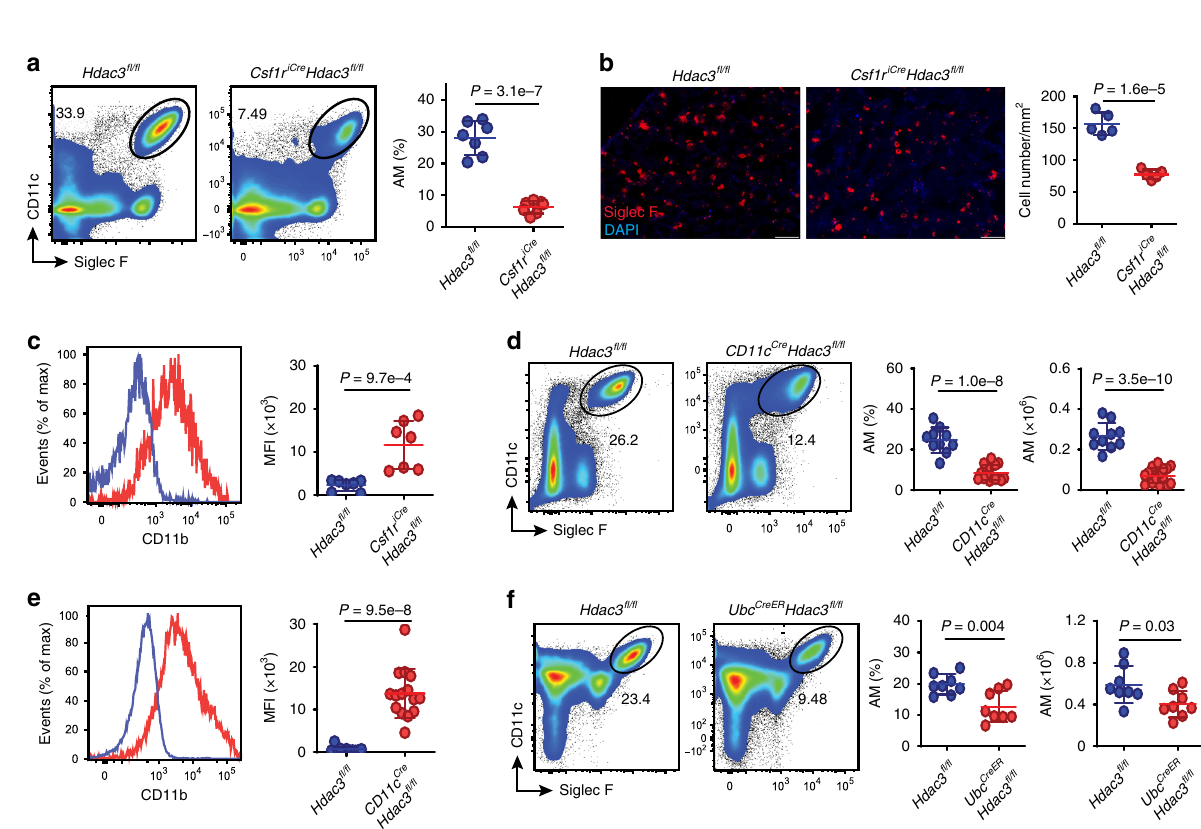
Fig. 2 HDAC3 is essential for the maintenance of mature AMs in the adult mice. a Flow cytometry for CD11c and Siglec-F expression of lung AMs within CD45 + live cells from n = 7 Hdac3 fl / fl ; Csf1r iCre Hdac3 fl / fl adult mice. Frequencies of AMs are shown on the right. b Lung tissue sections from adult mice as in a . Scale bars, 100 μ m. Cell numbers ( n = 5 Hdac3 fl / fl ;Csf1r iCre Hdac3 fl / fl ) are shown per tissue area (mm 2 ). c Histogram plot for CD11b expression of lung AMs from n = 7 Hdac3 fl / fl ; Csf1r iCre Hdac3 fl / fl adult mice. MFI, mean fl uorescence intensity. d Flow cytometry analysis of AMs from n = 10 Hdac3 fl / fl , n = 17 Cd11c Cre Hdac3 fl / fl adult mice. Frequencies and absolute numbers of AMs are shown on the right. e Histogram plot for CD11b expression of lung AMs from n = 11 Hdac3 fl / fl , n = 15 Cd11c cre Hdac3 fl / fl adult mice. MFI of CD11b is shown on the right. f Flow cytometry analysis of AMs from n = 8 Hdac3 fl / fl ; Ubc CreER Hdac3 fl / fl adult mice. Frequencies and absolute numbers of AMs are shown on the right. Each dot represents one mouse and bars represent mean ± SD of biologically-independent samples. All P values were obtained using the Student ’ s two-tailed unpaired t test. Source data are provided as a Source Data fi